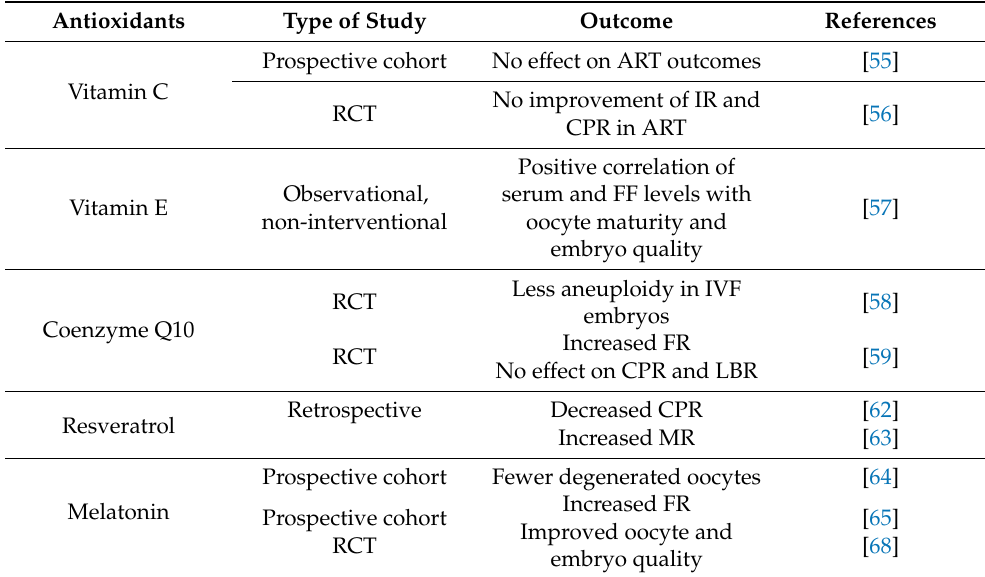
Table 3. Antioxidants in the treatment of age-unrelated ART